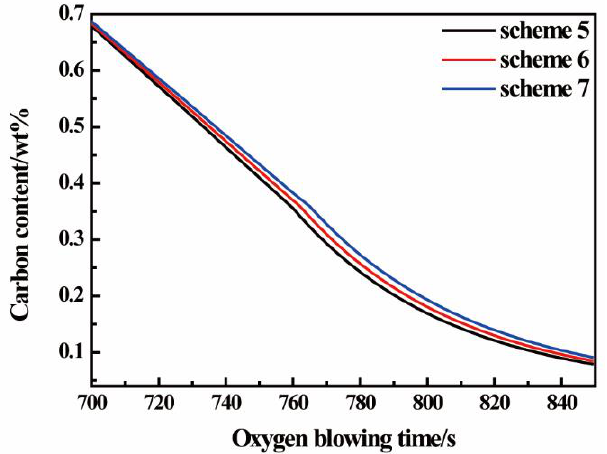
Figure 10. The influence of oxygen lance height in later stage on decarburization process.